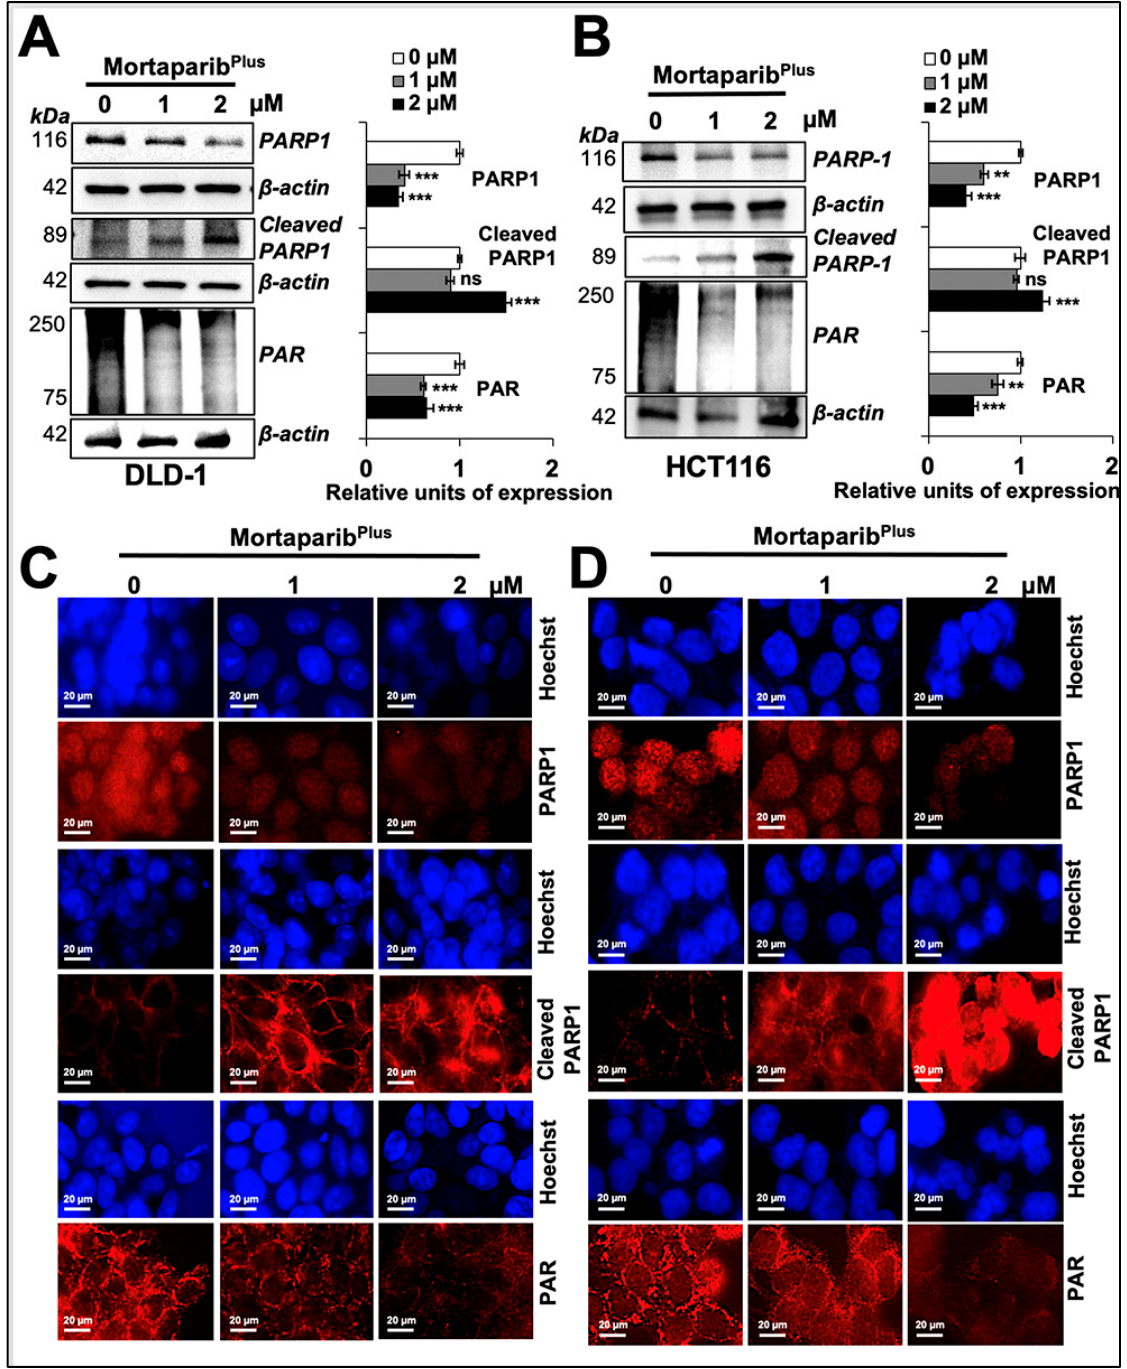
Figure 8. Mortaparib Plus -induced apoptosis in colorectal cancer cells resulted in the cleavage of PARP1 and the further decline in its catalytic activity. PARP1, cleaved PARP1, and PAR levels were analysed in control and 24 h Mortaparib Plus -treated cells by Western blotting ( A , B ) and immuno-cytochemistry ( C , D ). As compared to the untreated control, Mortaparib Plus -treated cells showed a decrease in full-length PARP1 with an increase in its 89-kDa cleaved fragment leading to the decumulation of PAR polymer. Scale bar in immuno-cytochemistry equals 20 μ m. The quantitation of immuno-cytochemistry results are provided in Supplementary Figure S4B. The data represent mean ± SD obtained from three independent biological replicates; p-values were calculated using unpaired Student’s t -test. ** < 0.01 and *** < 0.001 represent significant, very significant and very very significant, respectively.